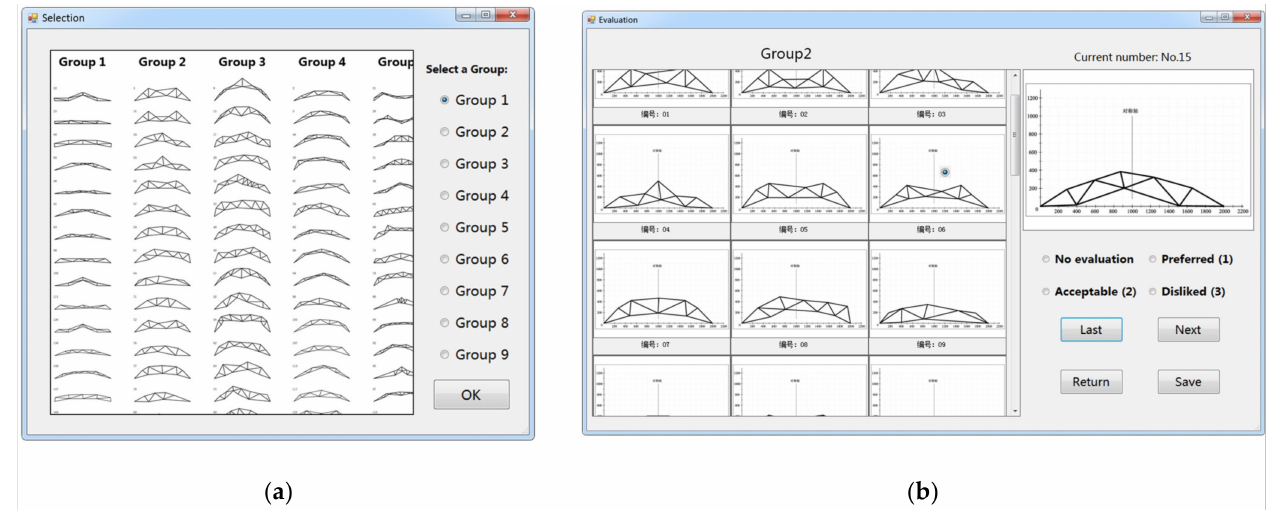
Figure 5. Screenshots of the interaction system: ( a ) Selection interface; ( b ) Evaluation